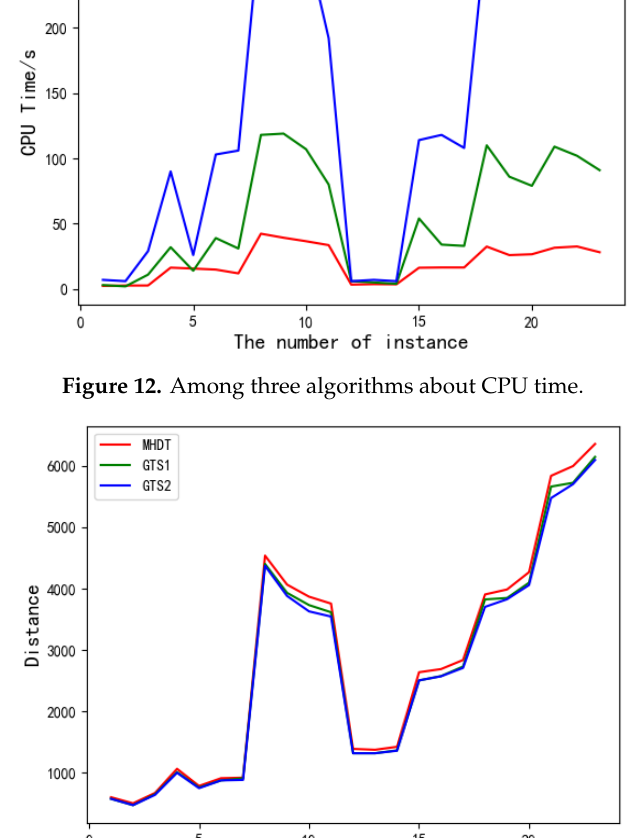
Figure 12. among three algorithms about CPU time.